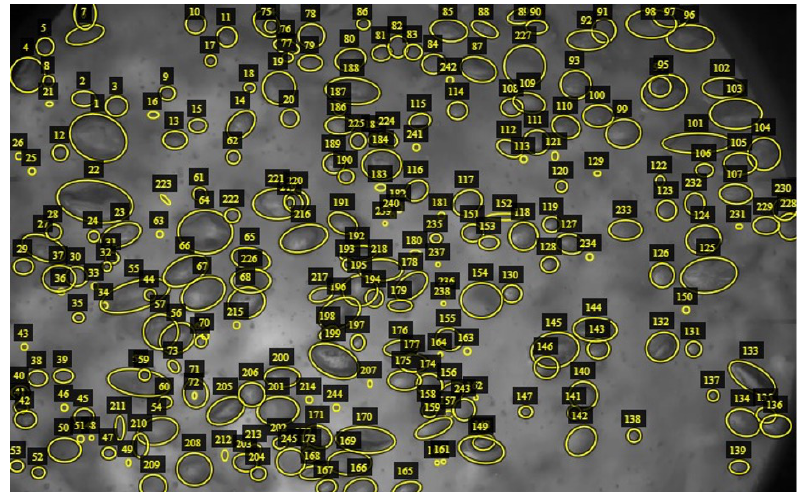
Figure 18. Labeled frame